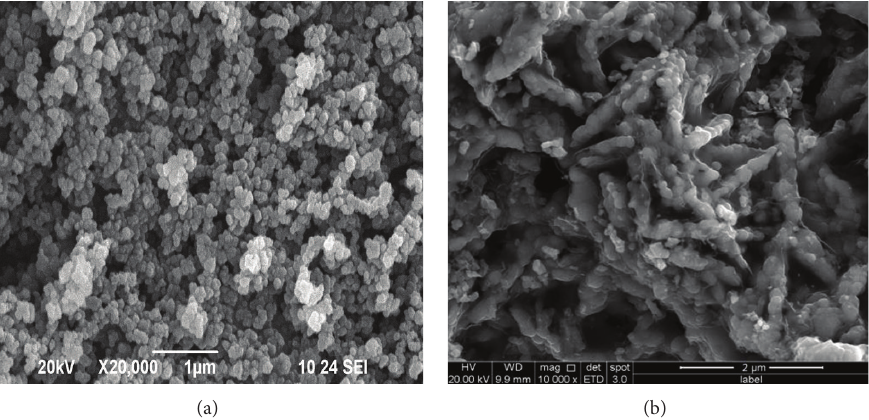
Figure 1: SEM images of nanosized spherical FePO 4 ⋅ 2H 2 O and LiFePO 4 /C.